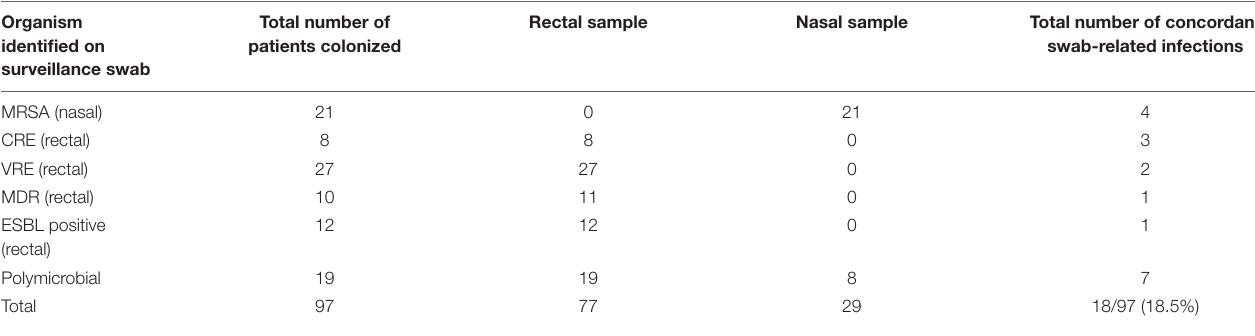
TABLE 2 | Results of surveillance swab and concordant swab-related infection. Organism identified